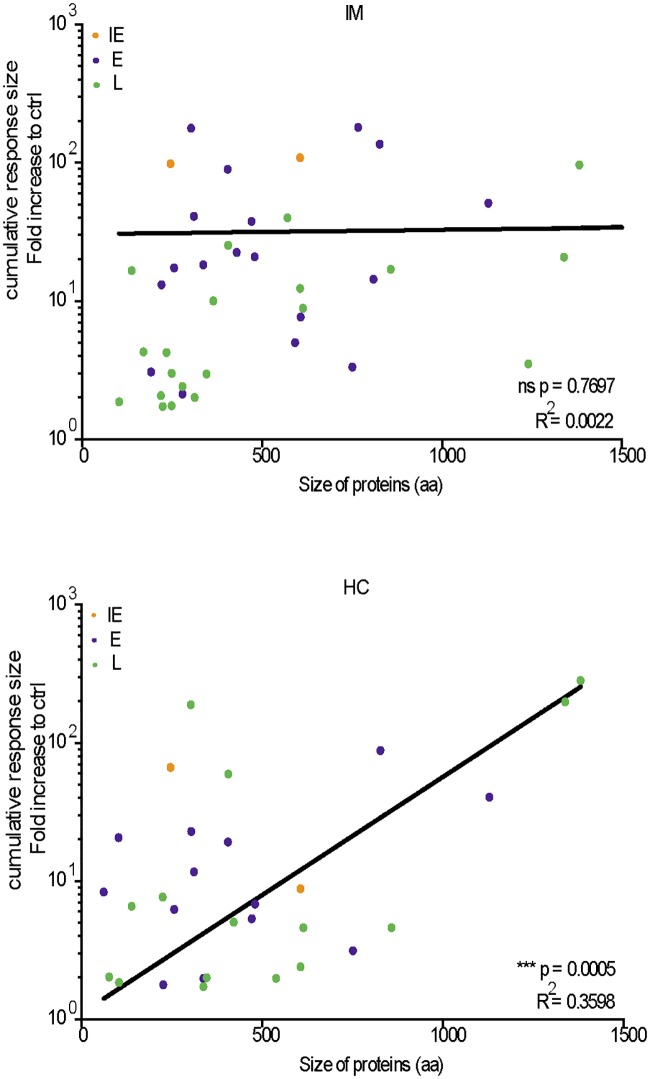
Comparison of the cumulative size of IM patient and healthy carrier responses to individual target antigens in relation to antigen size.For each group of donors, the response size shown for each antigen represents the sum of all individual response sizes to that antigen. Antigen size is shown as the number of amino acids in the primary sequence (allowing for any repeat sequences) as in S1 Table. Colour coding identifies IE (orange), E (purple) and L (green) antigens. Note that only those antigens that induced a detectable response are included in this analysis; for the purpose of presentation, we do not show the very small IM donor response to the large BPLF1 protein. Immunogenicity and antigen size were significantly correlated in healthy carrier responses (P = 0.0005, R2 = 0.3598).